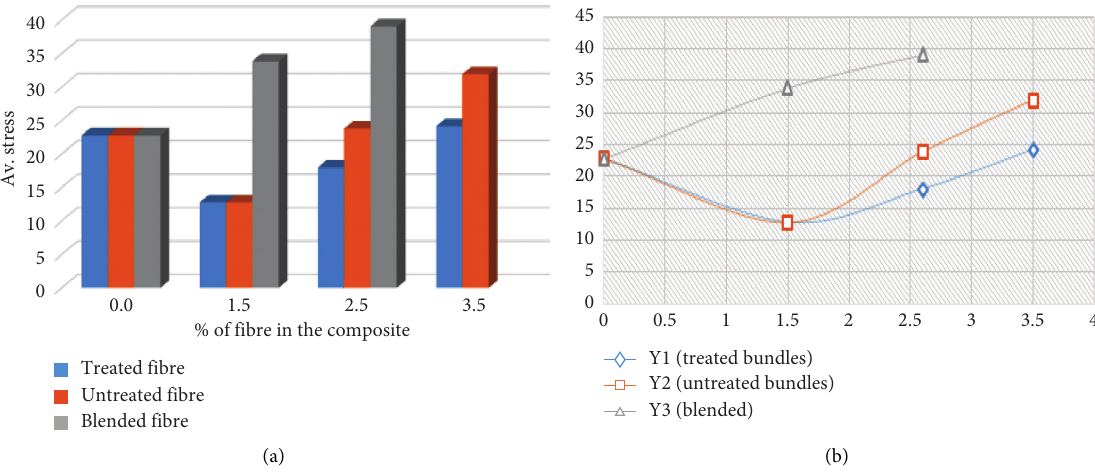
Figure 5: Rupture stress of the reinforced hybrid fibre/gypsum plaster composite at different wt. % fibre dosages.